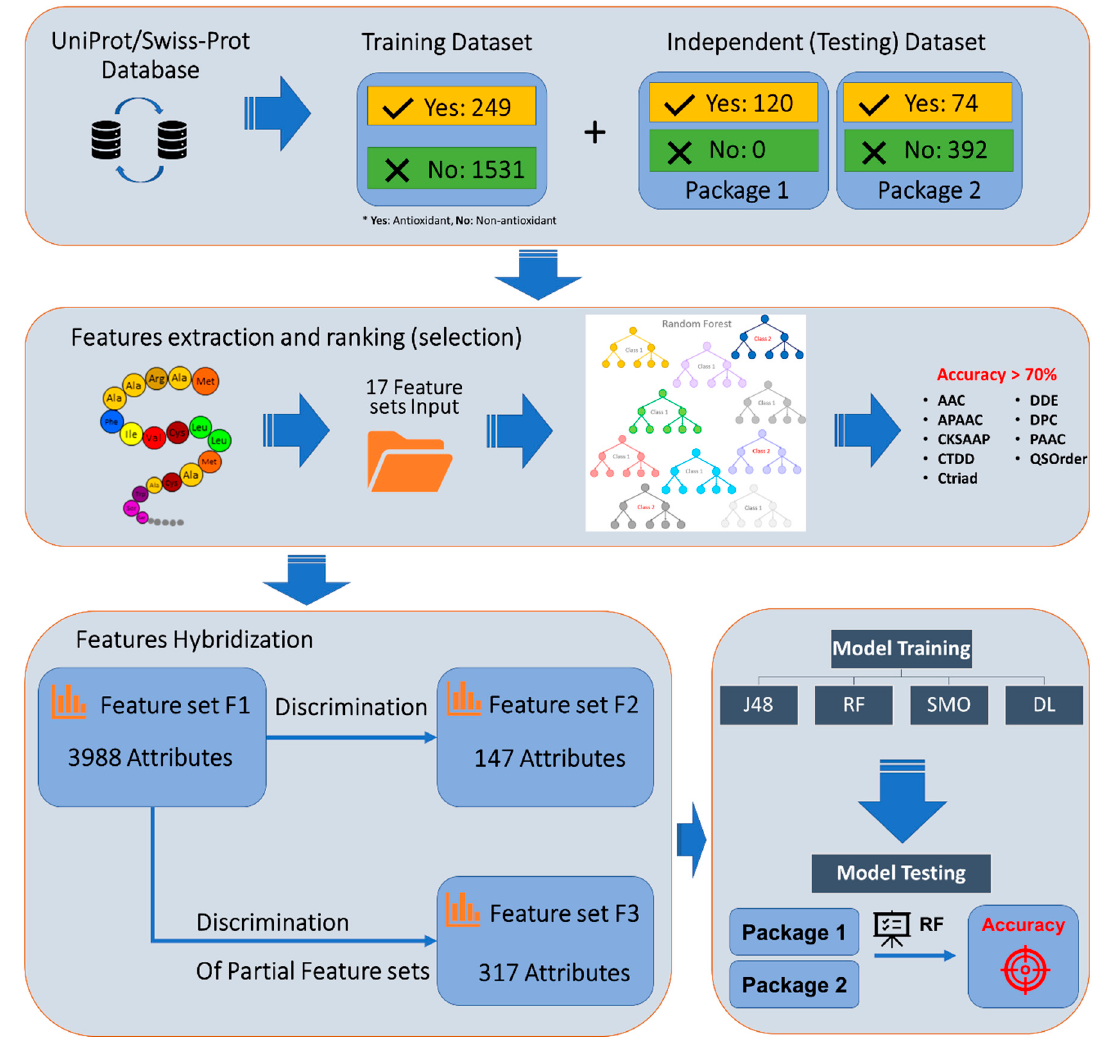
Figure 1. The flowchart summarizes the research processes.